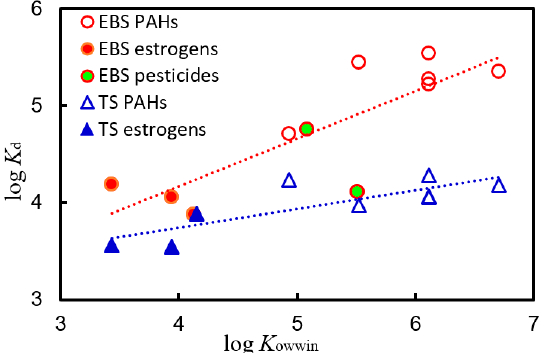
Figure 6. Relationship between log K owwin [27] and log K d . Red circles indicate IAPs formed from BTC and NaEBS, blue triangles indicate IAPs produced from Ben and TS, open red circles indicate PAHs (FL, BaA, BbF, BkF, BaP, and DahA), filled circles indicate estrogens (E1, E2, and EE2), and yellow-green filled circles indicate pesticides (pencycuron and pyrazolate). All IAPs were formed using BTC as an organic cation source. The filled red circles denote EBS as organic anions and the filled blue triangles denote TS.